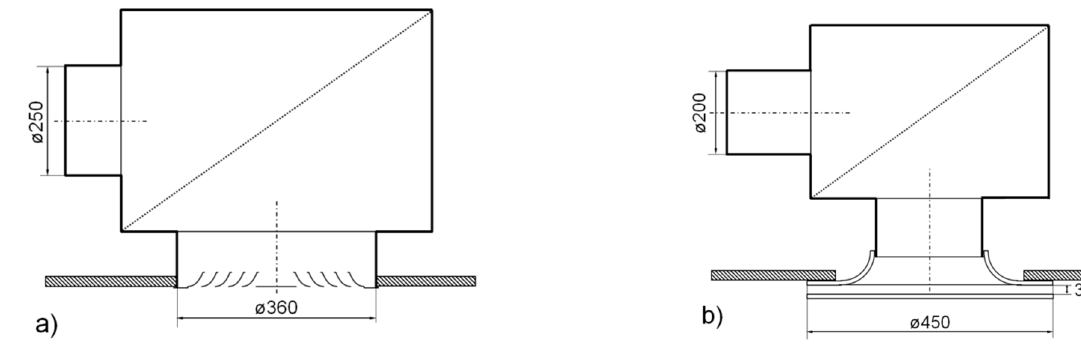
Figure 4. Diffusers used in the tests: ( a ) Multi-cone diffuser, ( b ) Plate diffuser.